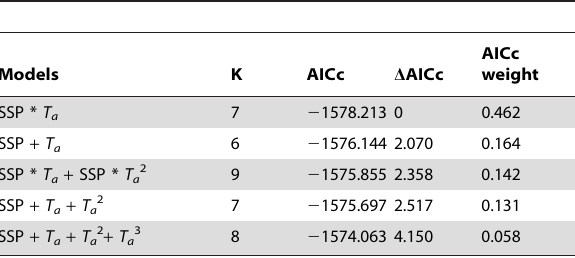
Table 4. Linear mixed models describing heat loss through the bill ( Q bill ).